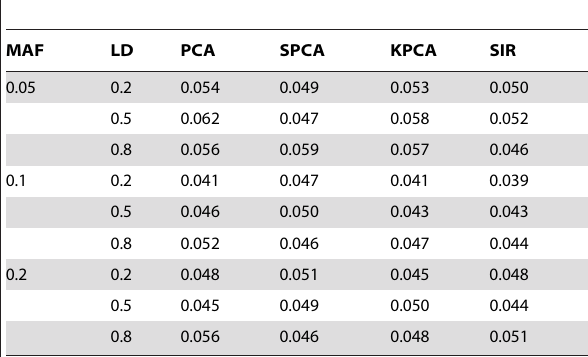
Table 5. Empirical type I error rates at the significance level of 0.05 based on 10